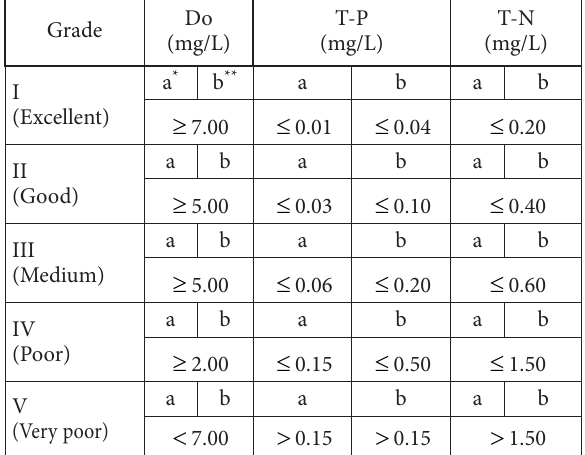
Table 8. Water quality standards in Saemangeum basin